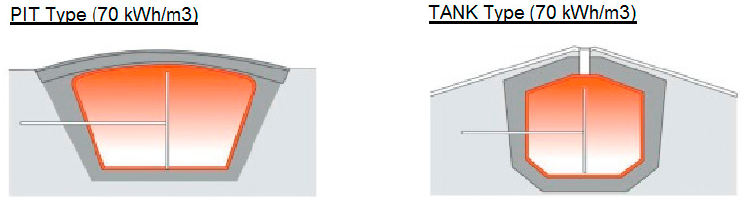
Figure 5. Insulated, atmospheric, thermal pits and thermal tanks, designed for thermocline layers.